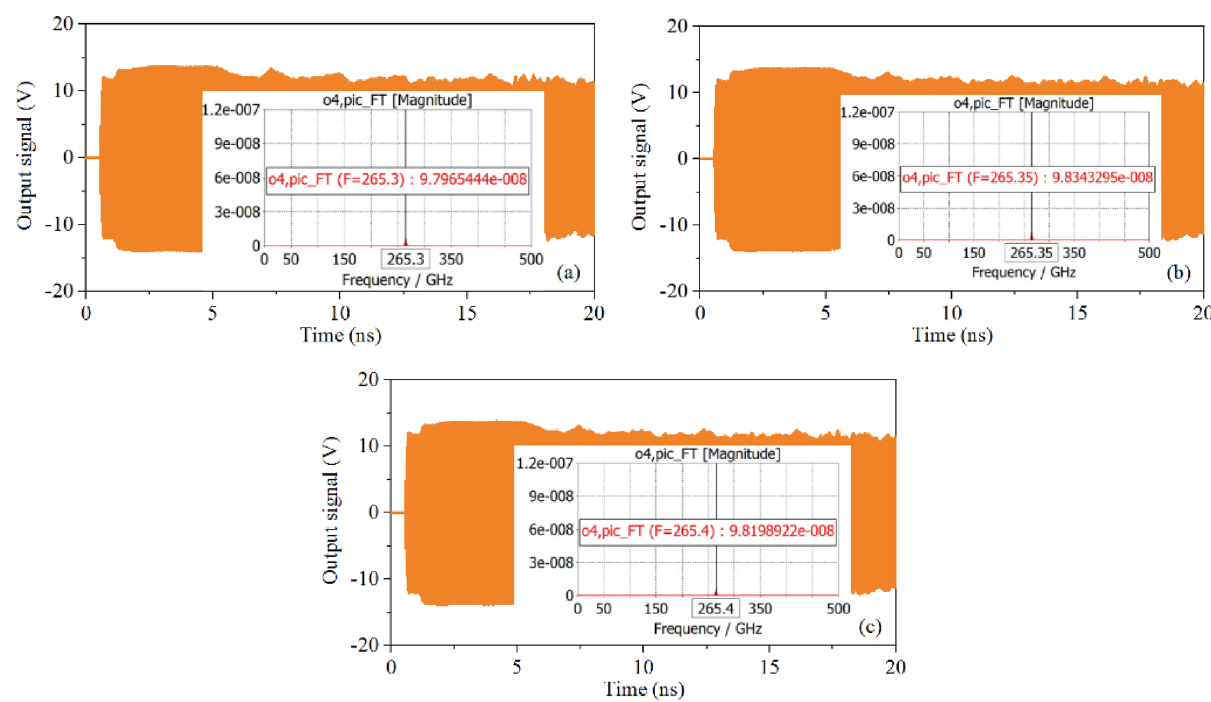
Figure 24. 20 ns output signal of SDV-SWS at ( a ) 265.3 GHz, ( b ) 265.35 GHz, ( c ) 265.4